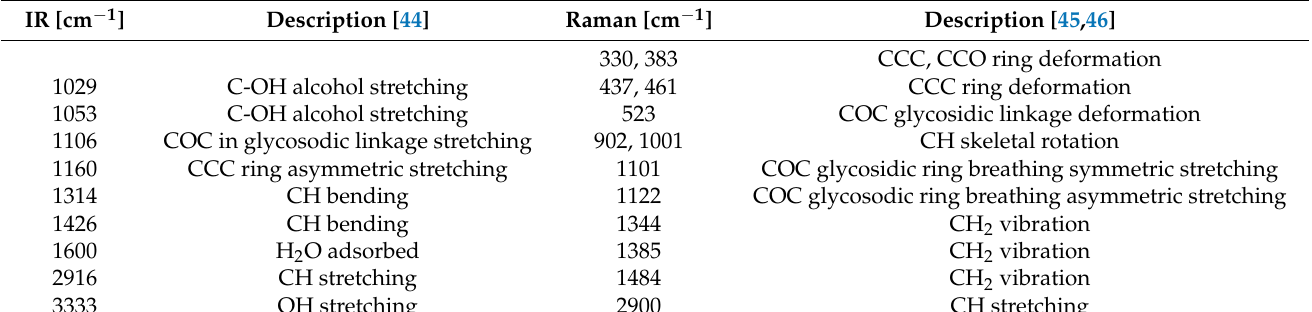
Figure 4. IR spectra of ( a ) washed cotton and cotton treated for 2 h with 2% H 2 SO 4 at various tem-